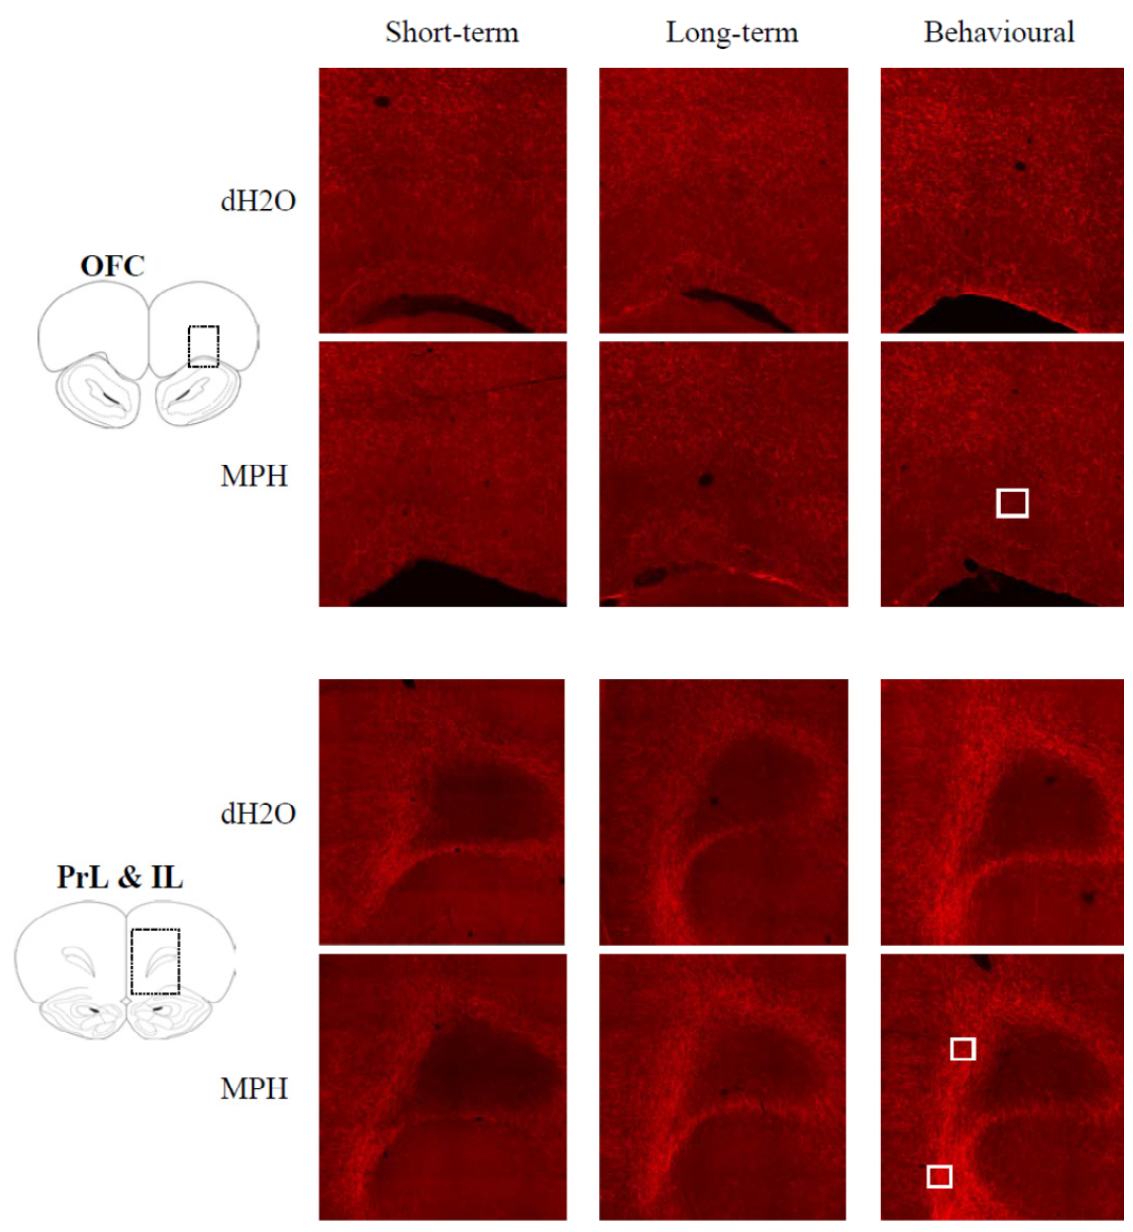
Figure 8. WKY rats: Images of tyrosine hydroxylase-ir fibres in the orbitofrontal cortex (OFC), prelimbic cortex (PrL; dorsal) and infralimbic cortex (IL) following chronic treatment with either methylphenidate (MPH) or distilled water (dH O). Immunohistochemical 2 staining was conducted in the short- and long-term groups, 1 and 12 weeks after cessation of treatment, respectively, and following behavioural testing (12 weeks post treatment) in the behavioural group. The white square represents the analysis probe in each region of interest (50,000 µm 2 ). Images have been adjusted for